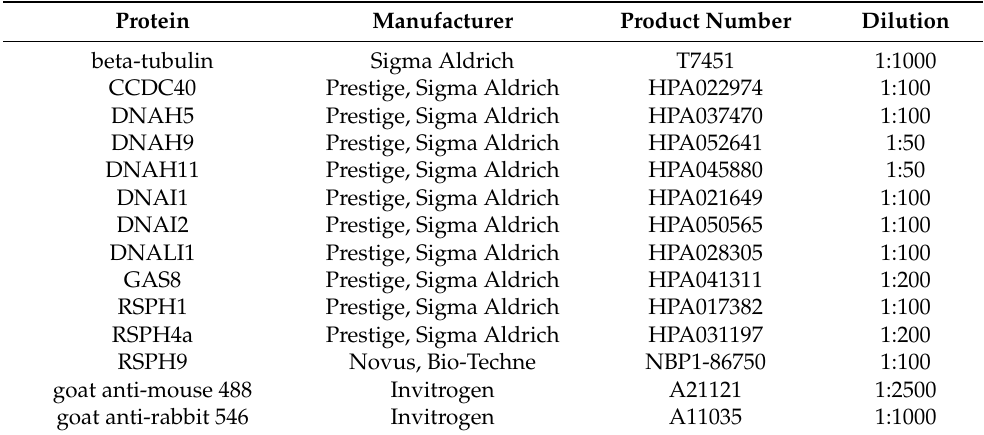
Table A1. Overview of the antibodies for the IF